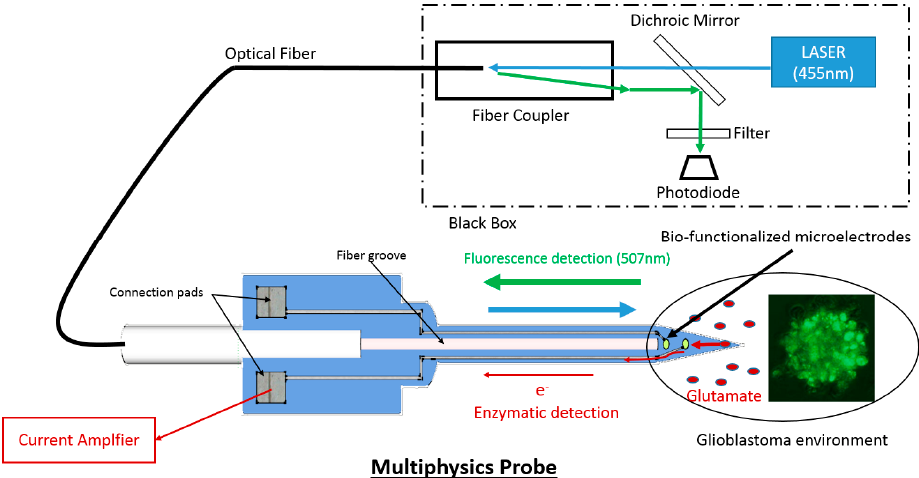
Figure 2. System Schematic for Fluorescence and enzymatic